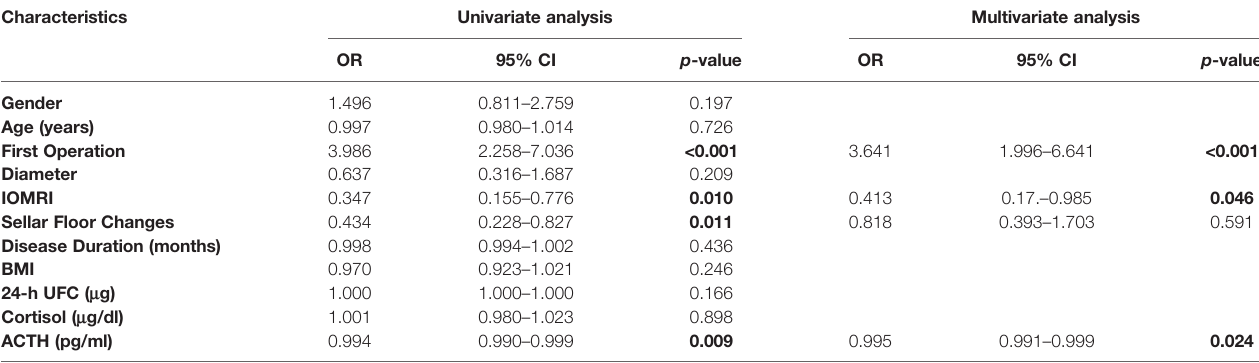
TABLE 3 | Logistic univariate and multivariate analysis of the relationship between risk factors and IR. Characteristics